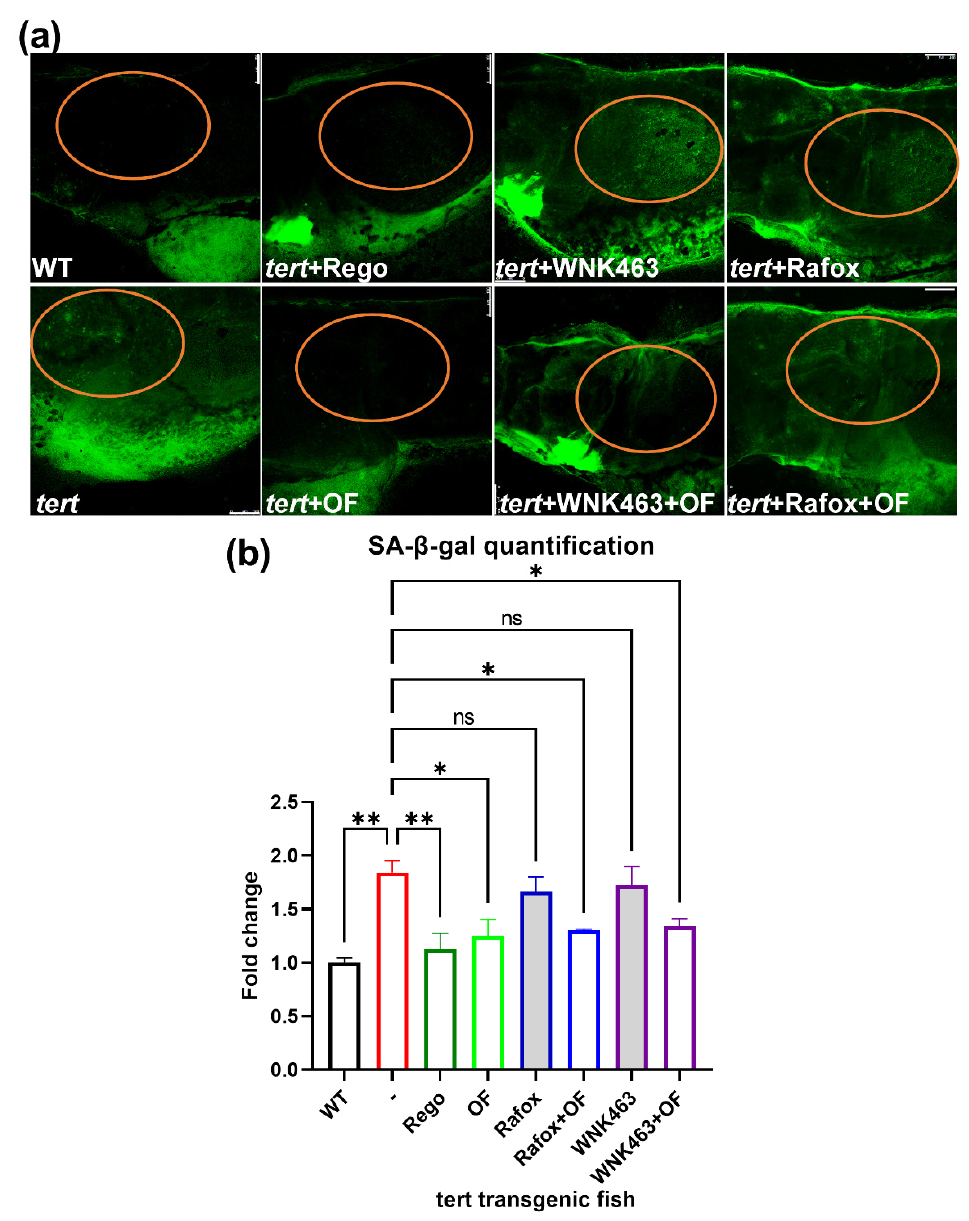
Figure 12. Oligo-fucoidan reduces the elevated senescence-associated β -galactosidase (SA- β -gal) expression by WNK1–OSR1 axis inhibitors in tert transgenic fish. We use Tg(fabp10a:tert; myl7:GFP) transgenic fish to further verify whether drugs can prevent cellular senescence. These fish were fed with a normal diet from 5 dpf to 10 dpf old and treated with several drugs: Regorafenib (0.5 µ M), oligo- fucoidan (0.3 mg/mL), WNK463 (0.625 µ M) with or without oligo-fucoidan, Rafoxanide(0.3 µ M) with or without oligo-fucoidan, and were then fixed and stained on 11 dpf. ( a ) The SA- β -gal expression in various combinations of drug-treated tert transgenic fish after various drug treatments. WT: AB(WT) fish as control, tert : Tg(fabp10a:tert; myl7:GFP) fish; OF: oligo-fucoidan-treated tert transgenic fish; WNK463: WNK1 inhibitor WNK463-treated tert transgenic fish; WNK463+OF: WNK463 plus oligo-fucoidan-treated tert transgenic fish; Rafox: OSR1 inhibitor Rafoxanide-treated tert transgenic fish; Rafox+OF: Rafoxanide plus oligo-fucoidan-treated tert transgenic fish. The scale bar is 100 µ m in length. The orange circle indicates the location of the liver. ( b ) Quantification of SA- β -gal staining. For each experiment, we performed three replicates. Ten larvae were included in each experiment. One-way ANOVA analysis followed by multiple analysis of variance was used to identify the statistical significance between groups. *: p ≦ 0.05; **: p ≦ 0.01; ns: no-significance.